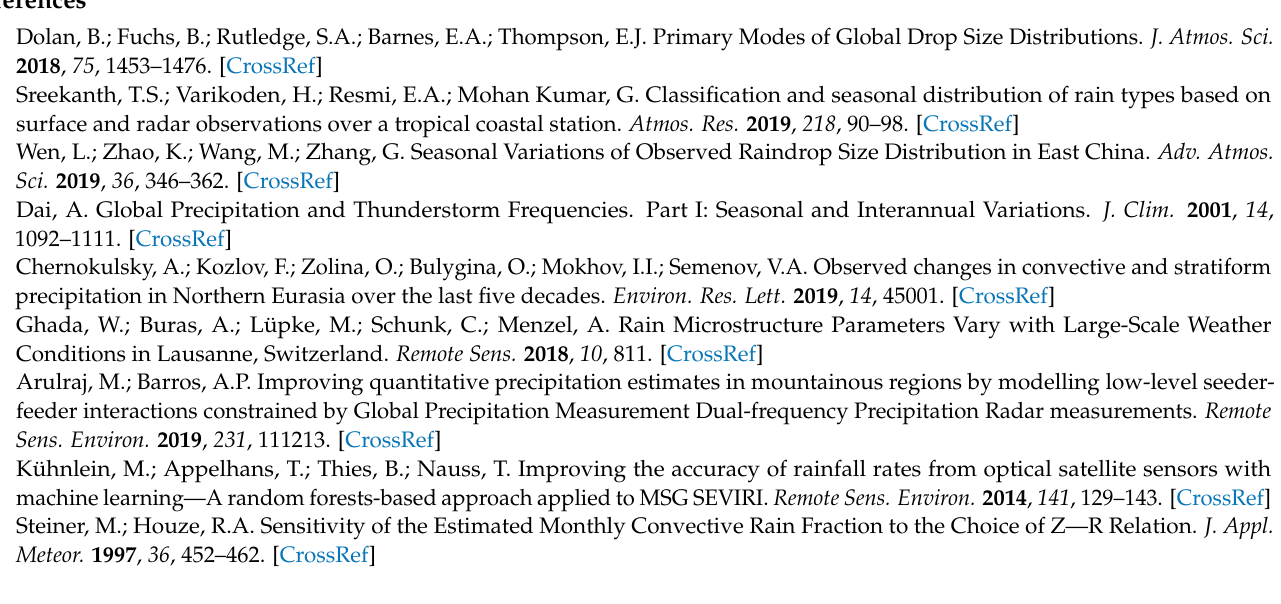
Figure A3. Event 191. The upper three panels represent the MRR measured values of reflectivity Z (dBZ), Doppler velocity W (m/sec), and spectral width SW (m/sec) respectively. The last panel represents rain intensity R (mm/h) as measured by the disdrometer.